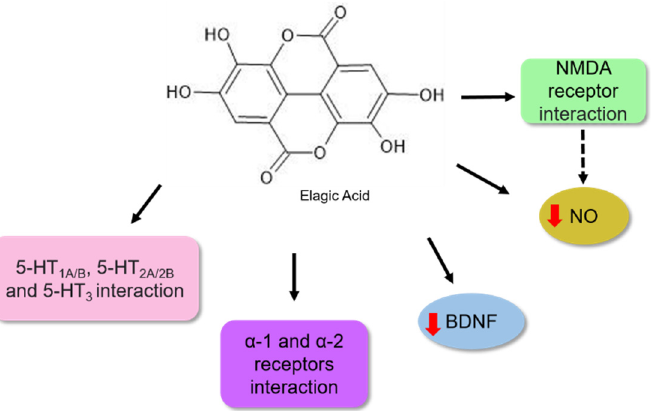
Figure 8. Possible mechanisms of action for ellagic acid as antidepressant based on preclinical trials. Studies have shown an association between serotoninergic, 5-HT1A/B, 5-HT2A/2B, and 5-HT3 receptors, and α -1 and α -2 adrenergic receptors in the antidepressant action of ellagic acid. Ellagic acid increased BDNF levels in the hippocampus. Its effect on the glutaminergic NMDA receptor was verified by modulating the expression of NR2A and NR2B subunits. This bioactive molecule may reduce the NO levels. This molecule may inhibit the NMDA-NO pathway and reduce nitric oxide levels, playing a part in the ellagic acid antidepressant effect. The red arrows (up) indicate increased levels and (down) reduced levels. The solid black arrow indicates stimulation, and the dashed black arrow indicates the possibility of activation (mechanism not directly evaluated in the study). The chemical structures were drawn using ChemSketch freeware, version 14.0 from ACD/Labs. Bedel et al. [106] observed that when BALB/c mice were treated with ellagic acid